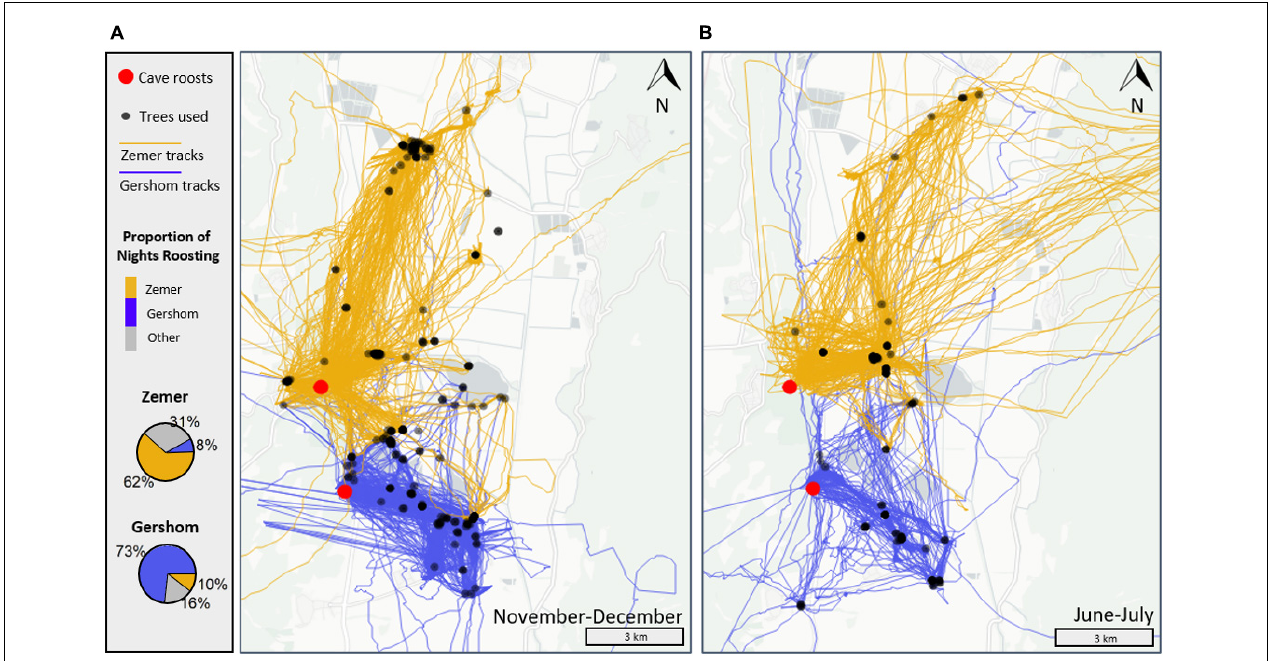
FIGURE 1 | Tracks of Egyptian fruit bats of two neighboring colonies, Zemer in yellow and Gershom in purple, showing resource (trees) and spatial (area) partitioning of foraging areas within the Hula Valley, Israel. Bats of both colonies show high fidelity to their cave-roosts (red spheres), expressed by the proportion of nights individual bats roosted in each focal cave (pie-charts per colony on the left panel). Gray portions of the pie-chart are the percent of cave switching nights from the focal cave to other caves. Black spheres are individual fruit trees visited by bats. Each map shows foraging movements within the (A) lean-fruit months of November-December (147 bat-nights of Gershom and 155 from Zemer, left map), and (B) during peaks of fleshy fruits in June-July (82 bat-nights Gershom and 108 Zemer, right map), accumulated across 2018–2020.